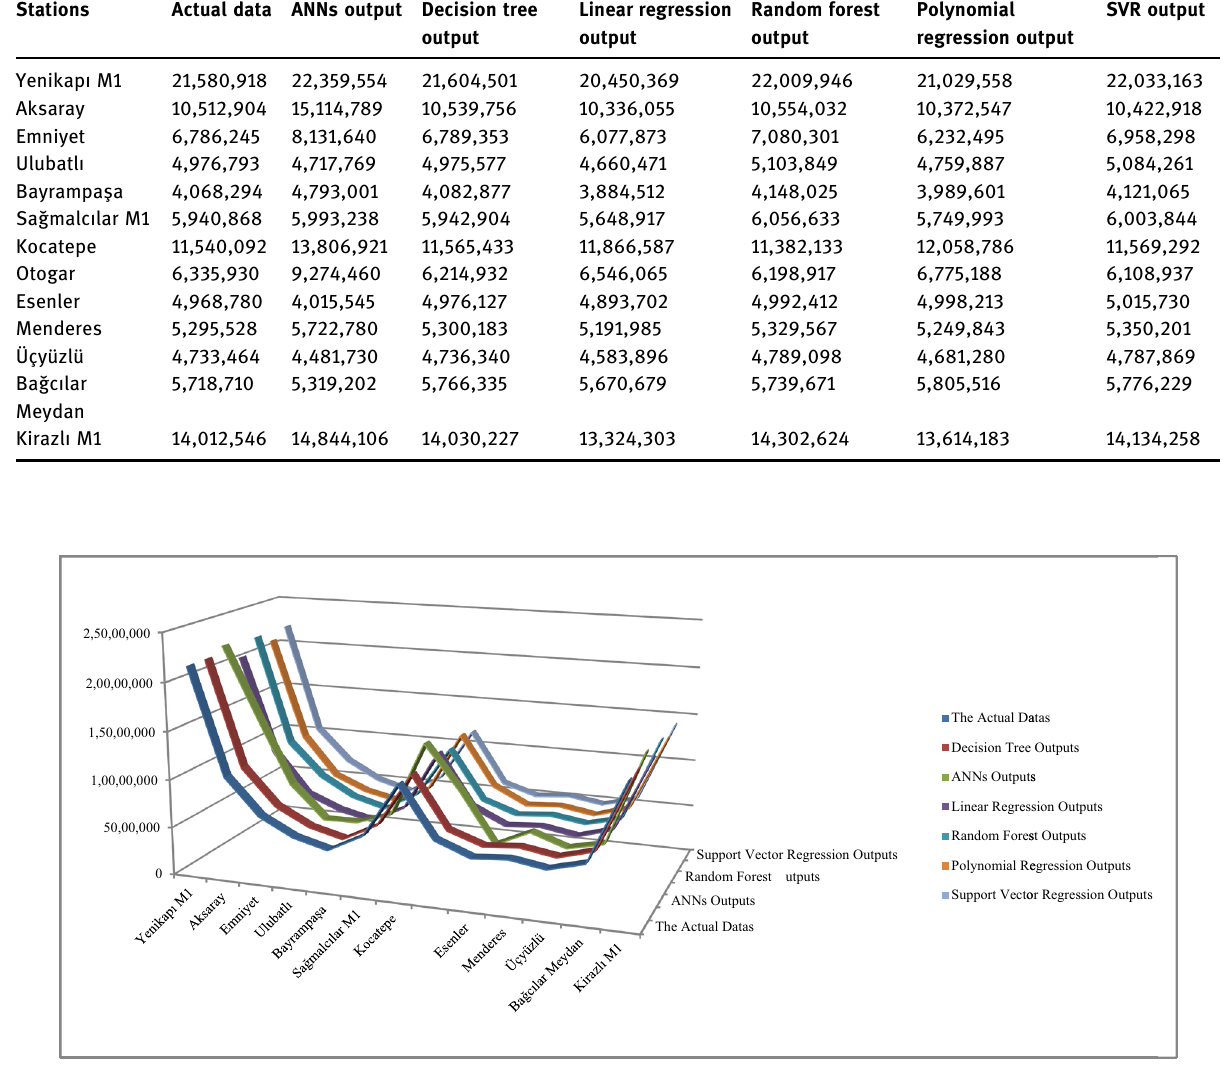
Figure 11: Comparison of the actual values and station based forecast values.